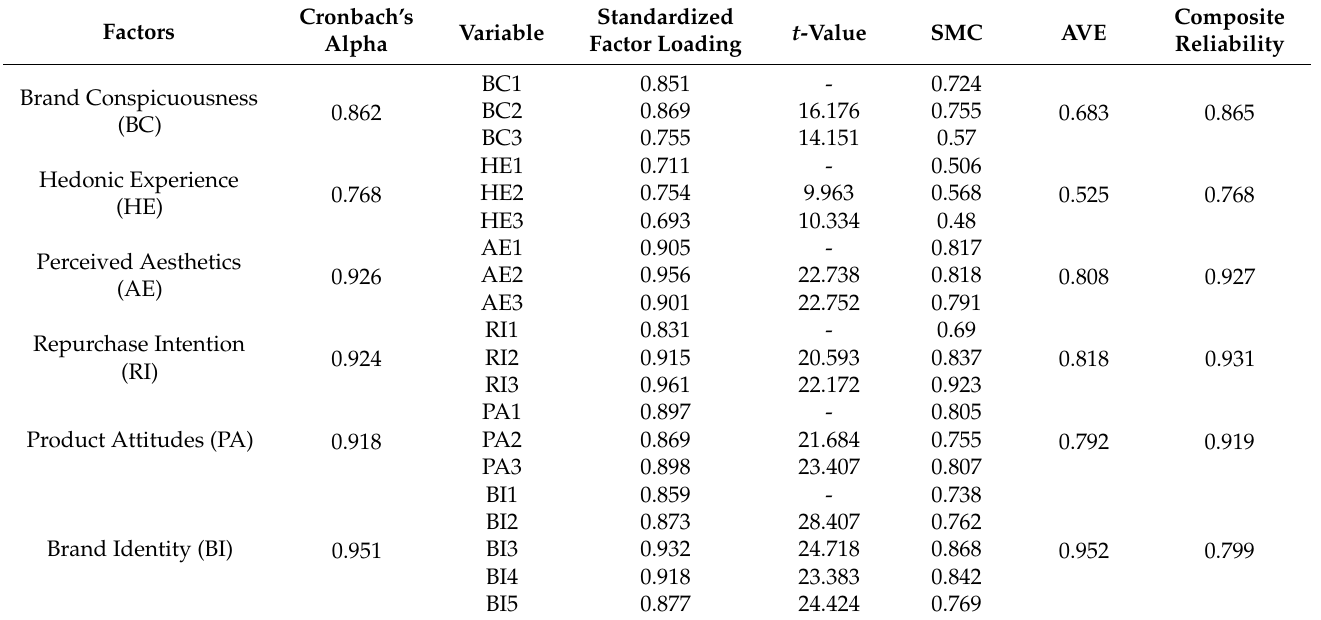
Table 3. Reliability and validity of the research.